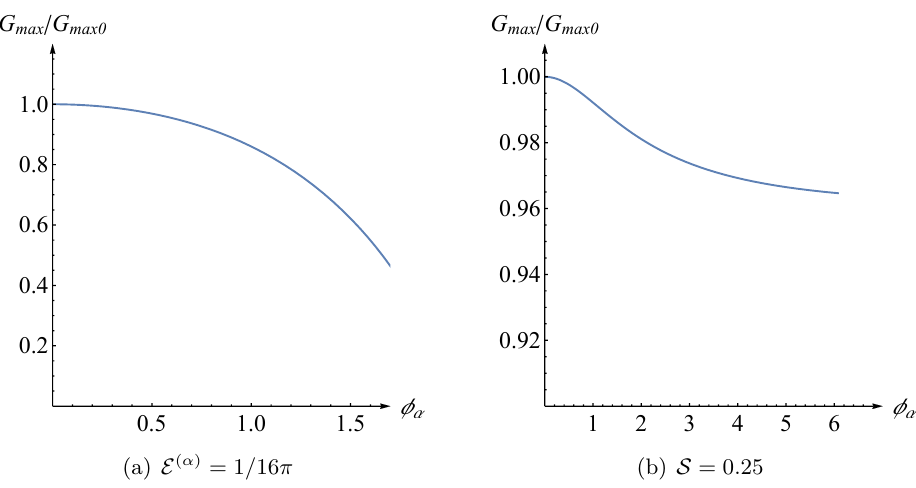
Figure 11 . For ‘ AdS = 1 , relationship between growth rate and φ α . Fixed the E = 1 / 16 π , S = 0 . 25 respectively, the larger the parameter φ α , the smaller the maximum value of the growth rate function G ( r )